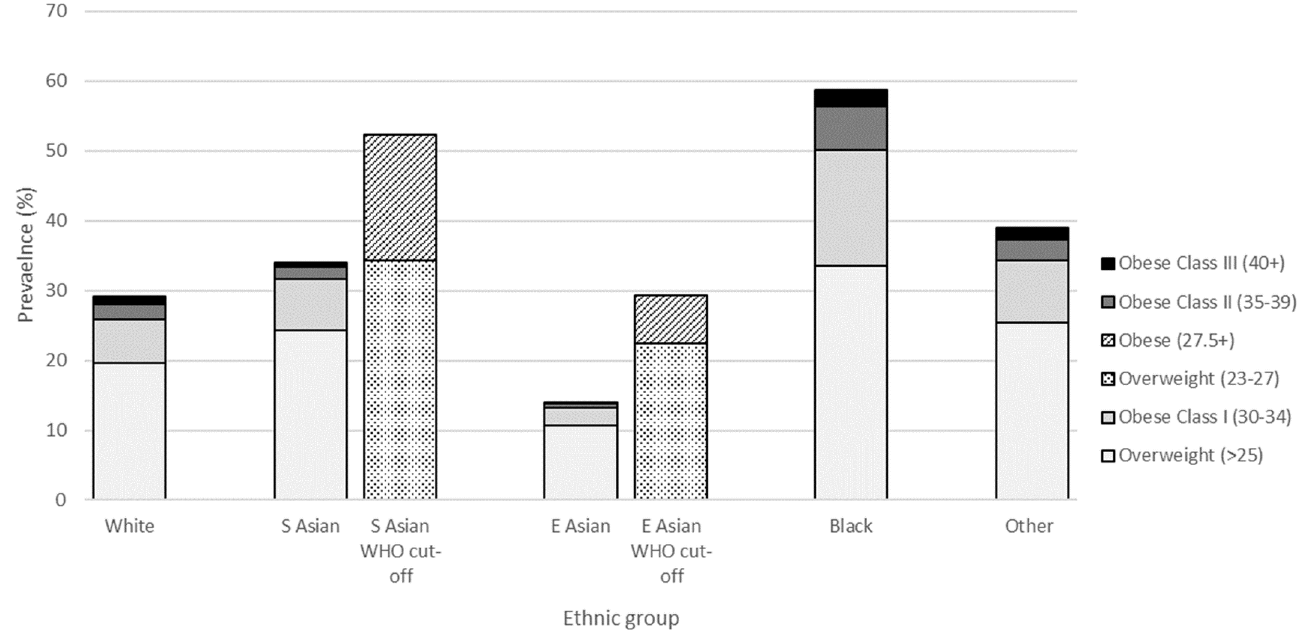
Fig 1. Prevalence of overweight/obesity by ethnic group, using conventional and Asian-specific thresholds.